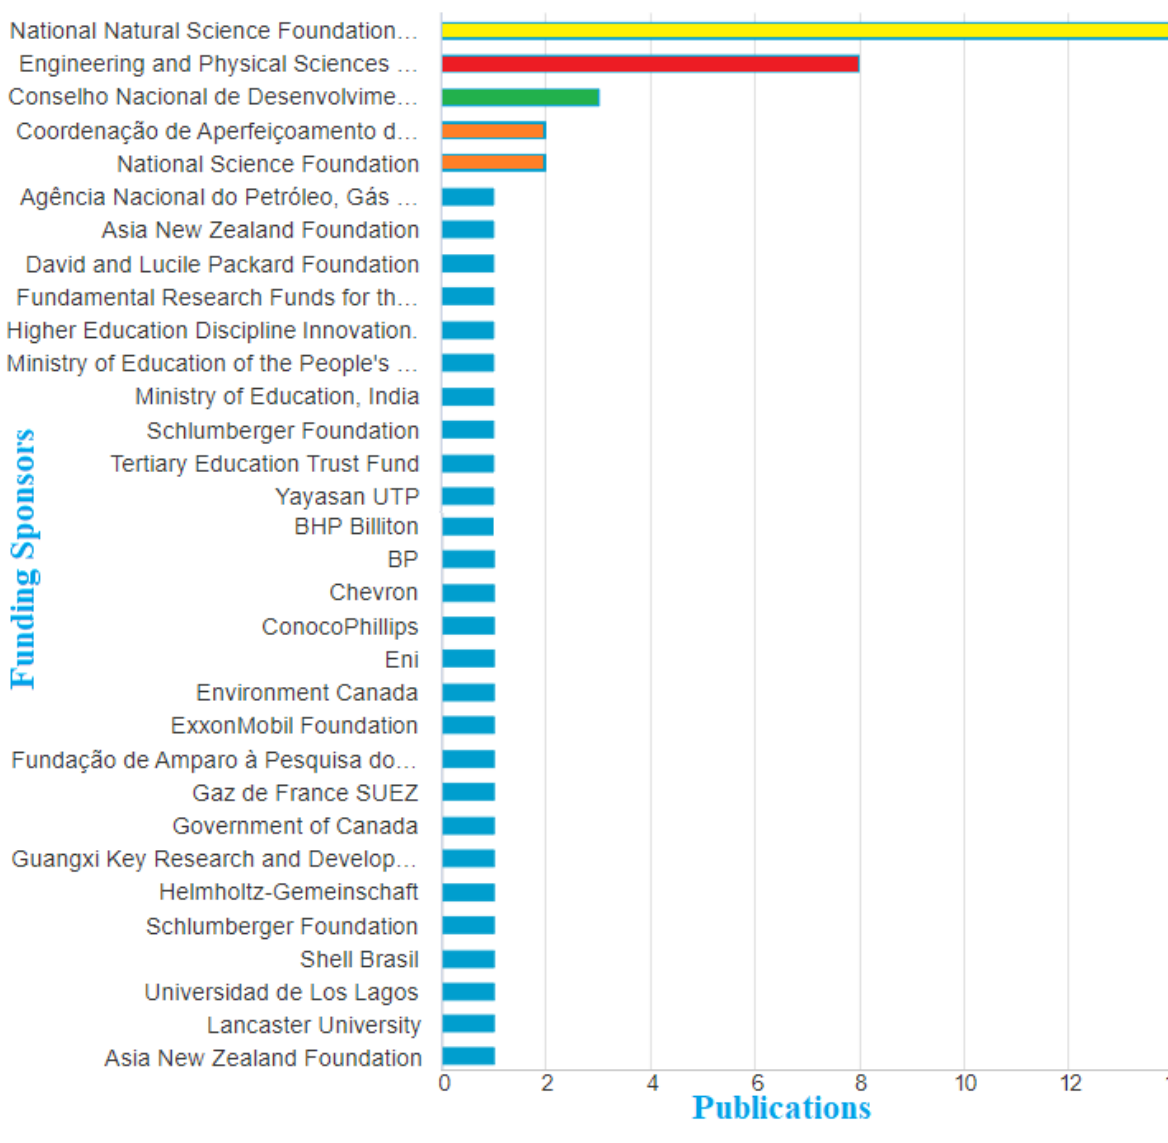
Figure 12. The affiliations by industry companies for the research on “marine hose” (data retrieved from Scopus database, 24 July 2022). Table 1. Funding details of the top fundings on marine hose research (data retrieved from WoS database, 24 July